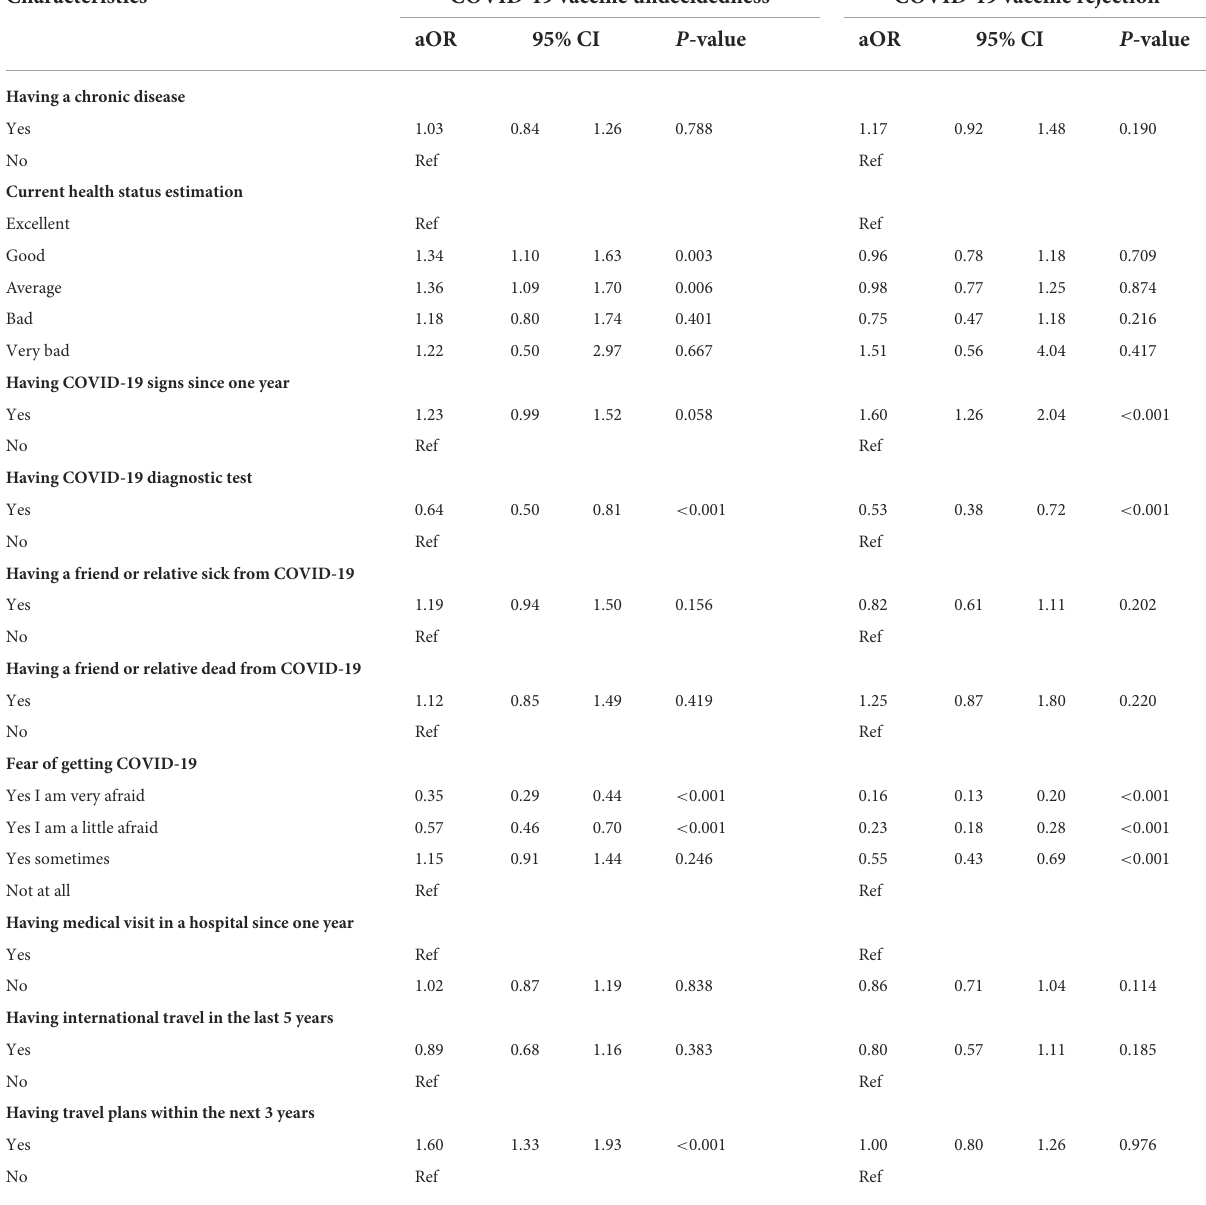
TABLE 5 Personal situations predictors of COVID-19 vaccine undecidedness or rejection: multivariate analysis. Characteristics COVID-19 vaccine undecidedness aOR